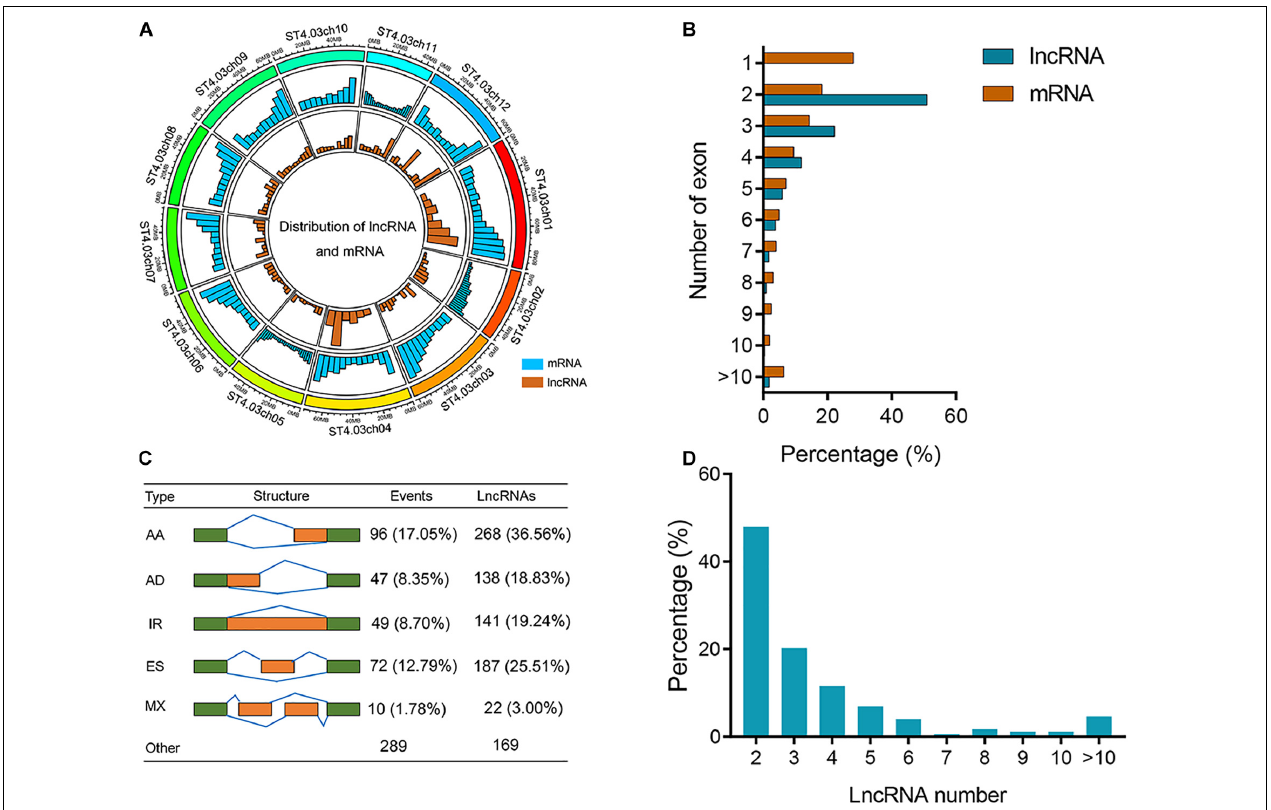
FIGURE 2 | Characterization of potato lncRNAs. (A) Distribution of lncRNAs and mRNA along each potato chromosome. The abundance of lncRNA and mRNA in physical bins of 10 Mb for each chromosome (generated using Circlize). (B) Percentage of lncRNAs and mRNAs containing different numbers of exons. (C) Classification of AS events. Cartoons show five major types of AS events, including IR, AD, AA, ES, and MX. The numbers of AS events and associated lncRNAs are shown. Numbers in parentheses show the proportions of lncRNAs generated from different types of AS events occupying all AS lncRNAs. (D) Percentage of genes containing different numbers of